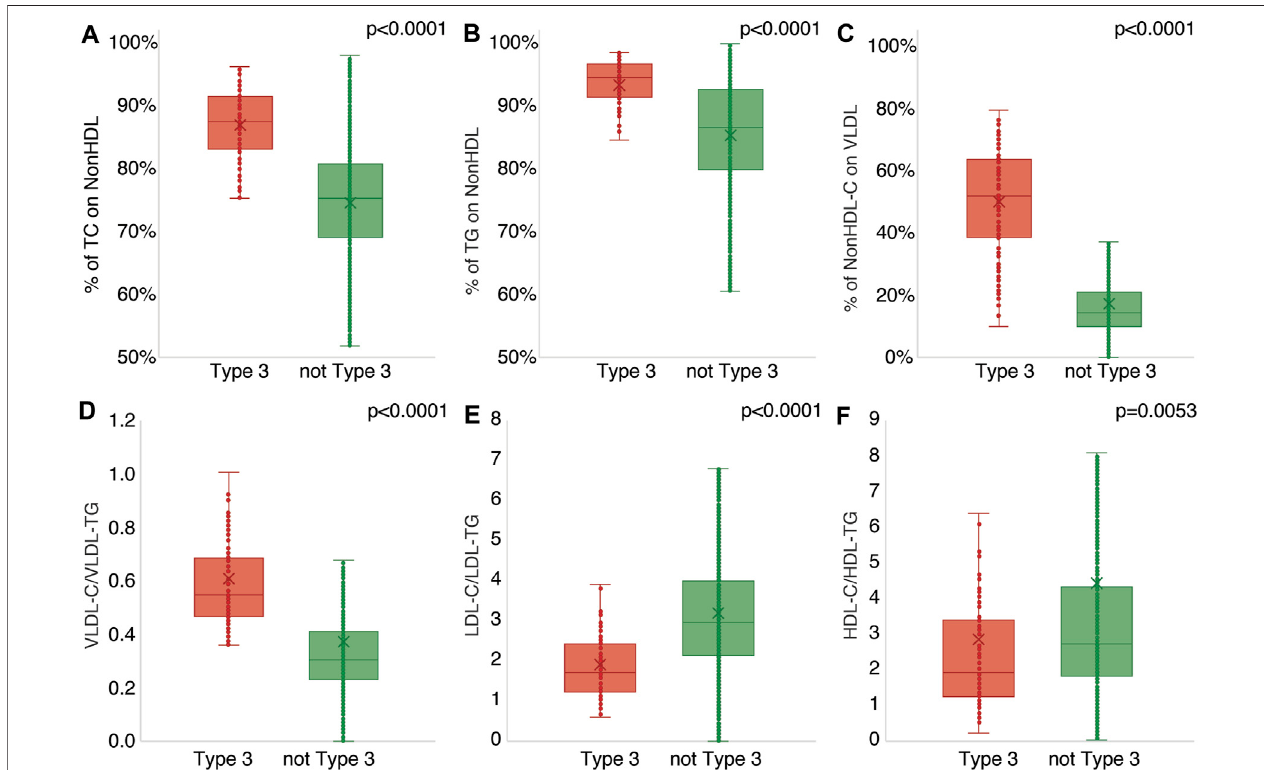
FIGURE1 | Comparison oflipid ratios betweenHLP3 and non-HLP3patients. Specimensdetermined tohave HLP3 (N= 115, red)by BQwere compared against thosewithoutHLP3(N=24,431,green)forthe%ofTConnon-HDL (A) ,%ofTGonnon-HDL (B) ,%ofnon-HDL-ConBQVLDL (C) ,theratiosofVLDL-C/VLDL-TG (D) , LDL-C/LDL-TG (E) , and HDL-C/HDL-TG (F) .